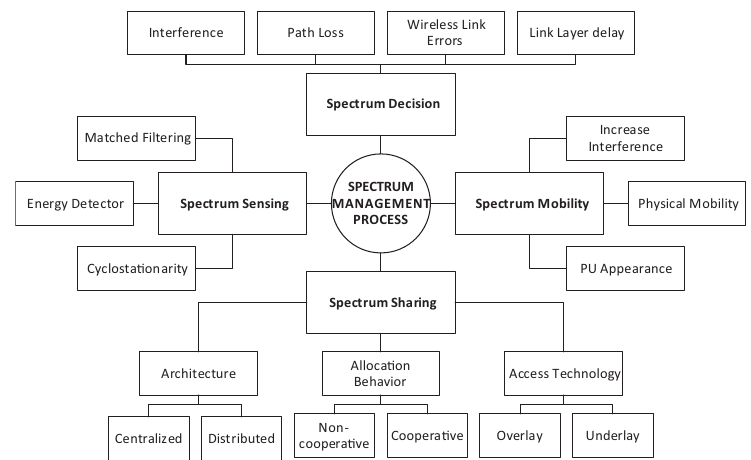
Figure 2. Spectrum management